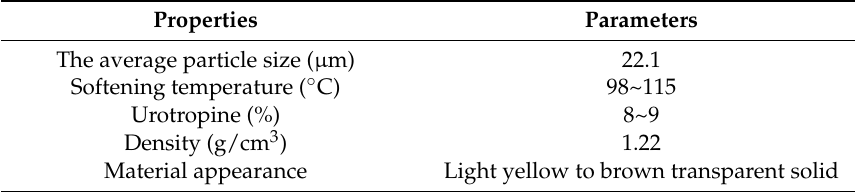
Table 1. The characteristics of the PF-2123 phenol formaldehyde resin.